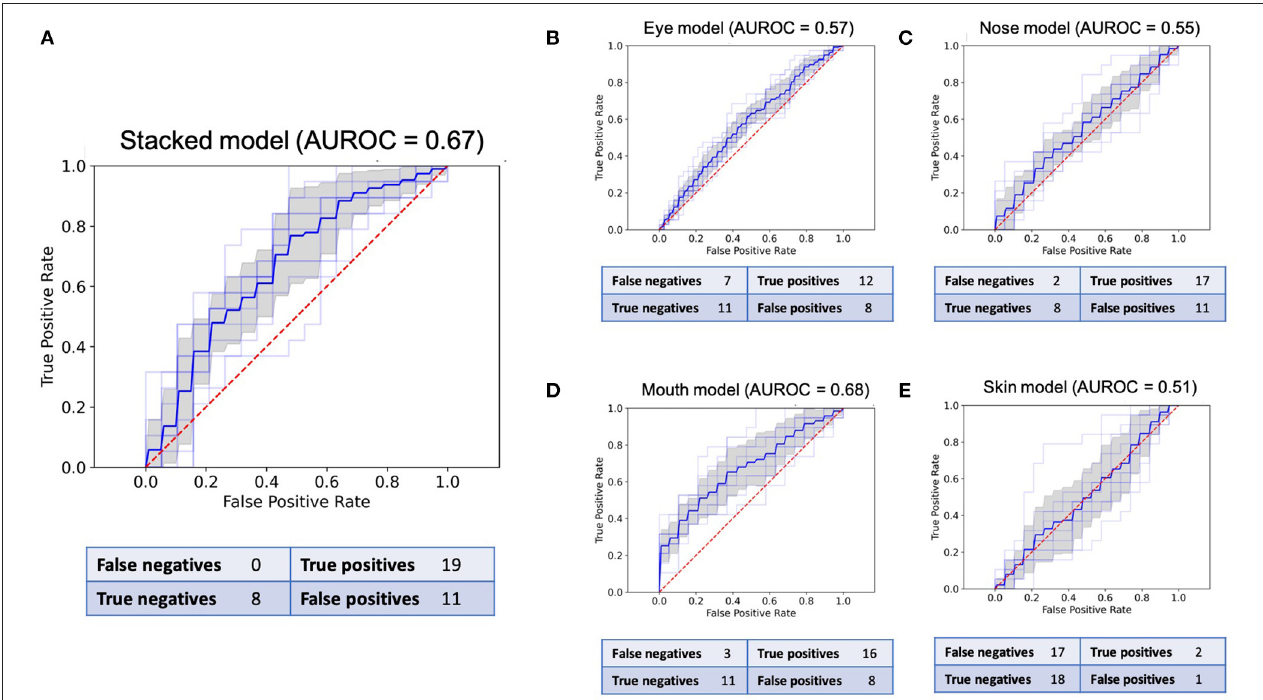
FIGURE 3 | Receiver operating characteristic (ROC) curves and confusion matrices for the final model of all five CNNs in the validation set of 38 images. (A) : ROC for the stacked model. (B) : ROC for the eyes. (C) : ROC for the nose. (D) : ROC for the mouth. (E) : ROC for the skin. values for beta1 = 0.9, beta2 = 0.999, and epsilon = 10 − 8